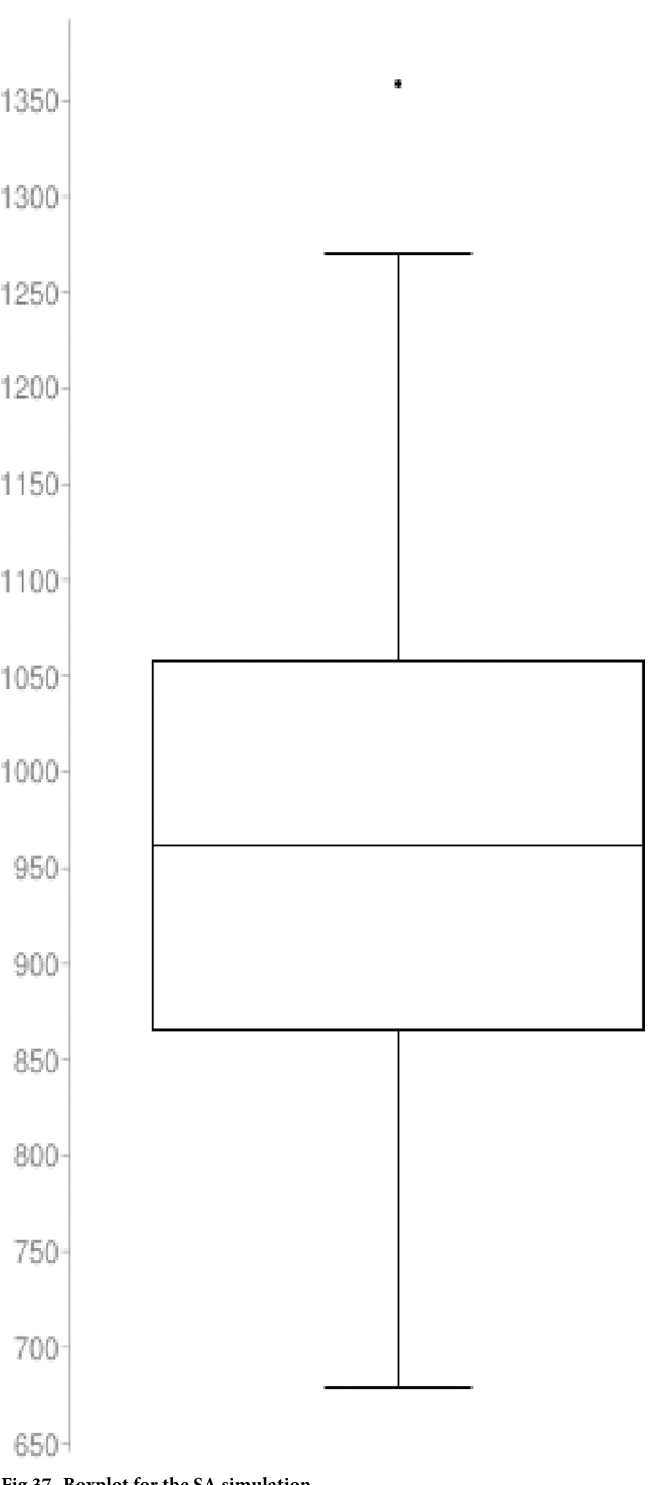
Fig 37. Boxplot for the SA simulation.